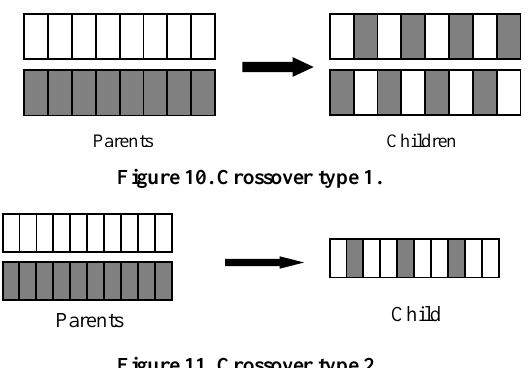
Figure 11. Crossover type 2.